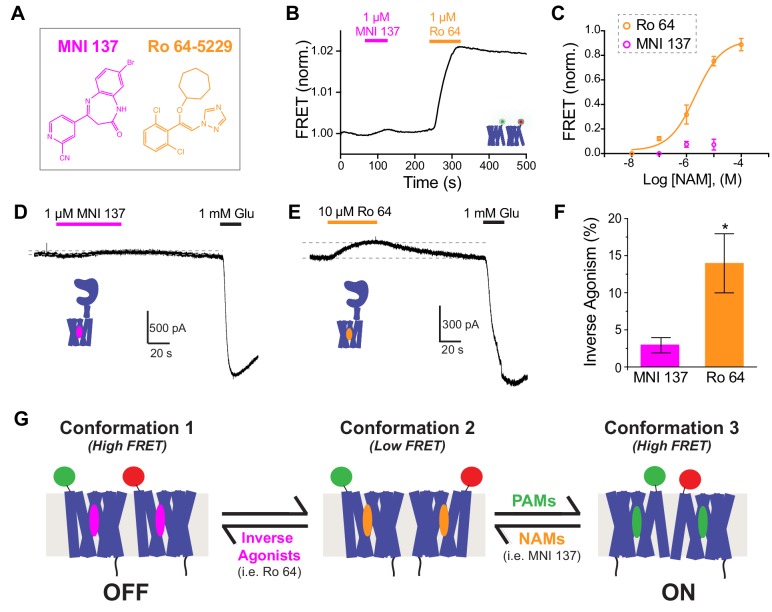
Inverse agonism or neutral antagonism of NAMs is associated with the presence or absence of an inter-TMD FRET Response.(A) Chemical structures of the mGluR2 NAMs, MNI 137 and Ro 64–5229. (B) Representative inter-TMD FRET trace showing the lack of a response for MNI 137, but a large FRET increase in response to Ro 64 application. (C) Inter-TMD FRET dose–response curves showing a large dose-dependent response for Ro 64 with an EC50 of 2.1 ± 0.2 μM. Values are normalized to saturating LY48 and come from at least three separate experiments per conditions. Error bars show s.e.m. (D–F) Functional evidence for neutral antagonism of MNI 137 and inverse agonism of Ro 64. Representative current traces show no effect on baseline levels for MNI 137 (G), but a clear outward current for Ro 64 (H). Results are summarized in (F). Error bars show s.e.m. * indicates statistical significant (unpaired t-test, p=0.04). (J) Working three-state model accommodating a FRET increase for application of either PAMs or inverse agonists. A combination of distinct inter-TMD interfaces and differences in intra-TMD conformation likely underlie the different FRET values.